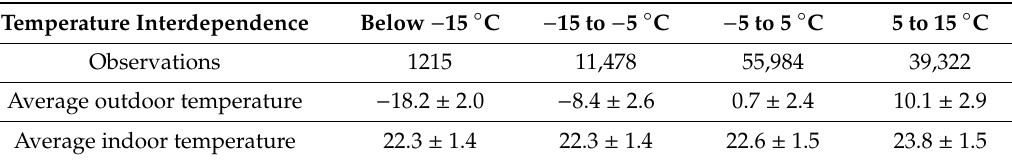
Figure 10. The distribution of indoor temperatures at di ff erent outdoor temperatures after renovation. Even with the outdoor temperatures ranges, the average indoor temperature is quite stable, ranging from 22.3 to 23.8 degrees (see Table 6). Table 6. The average indoor temperatures connection to ranging outdoor temperature during the heating season after